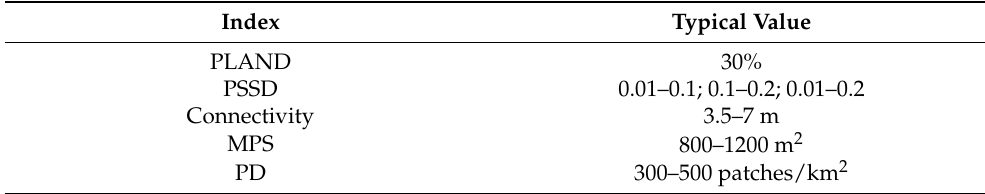
Table 2. Typical values of green space pattern